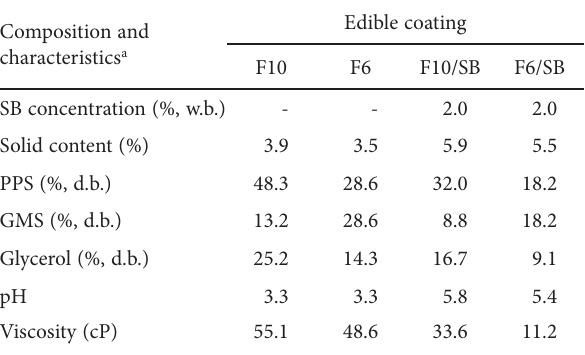
Table 2. Composition and characteristics of the edible fruit coatings evaluated in this